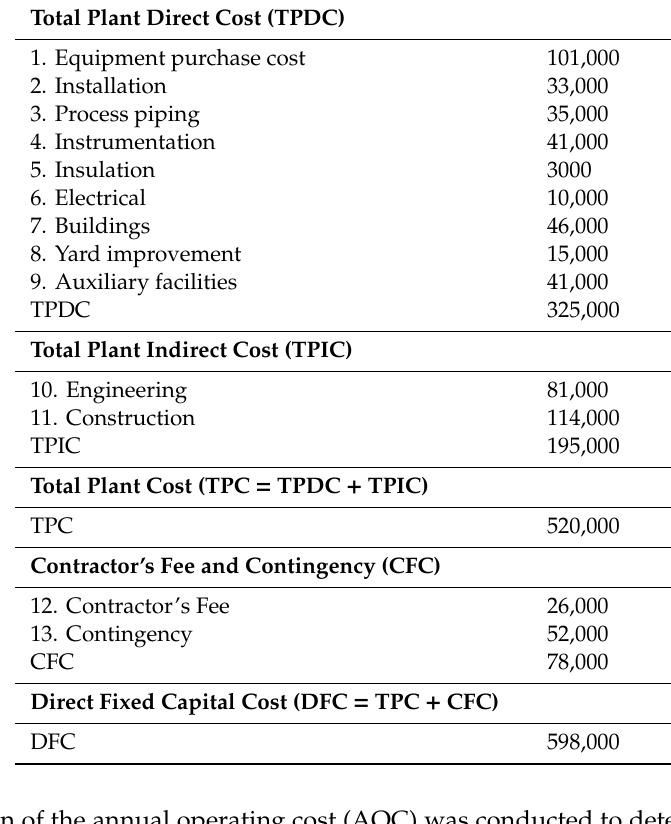
Table 5. Fixed capital estimate summary (2020 prices in $).